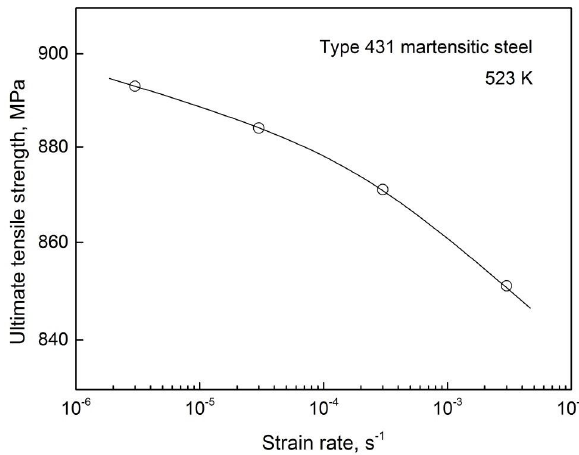
Figure 9: AISI 431 martensitic stainless steel exhibited negative strain rate sensitivity in terms of decreasing ultimate tensile strength values with increasing nominal strain rate at 523 K.